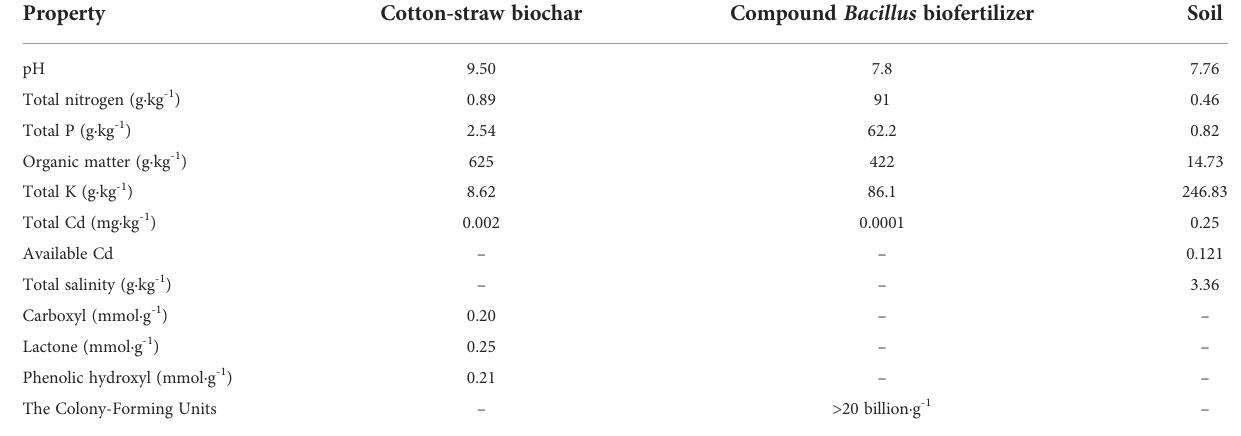
TABLE 1 Physicochemical properties of modi fi ers and soil.